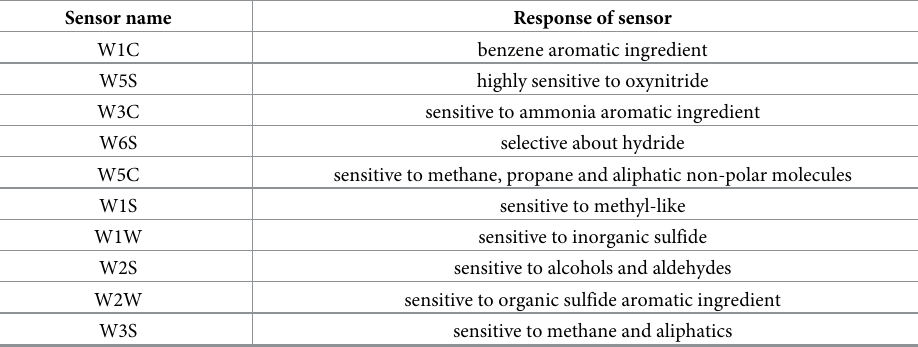
Table 1. Response features of the sensor